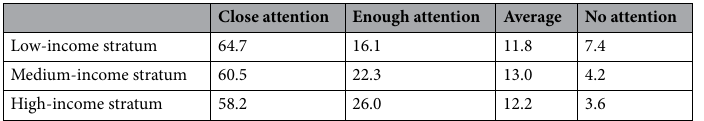
Table 4. Attentions of residents to food safety Unit: